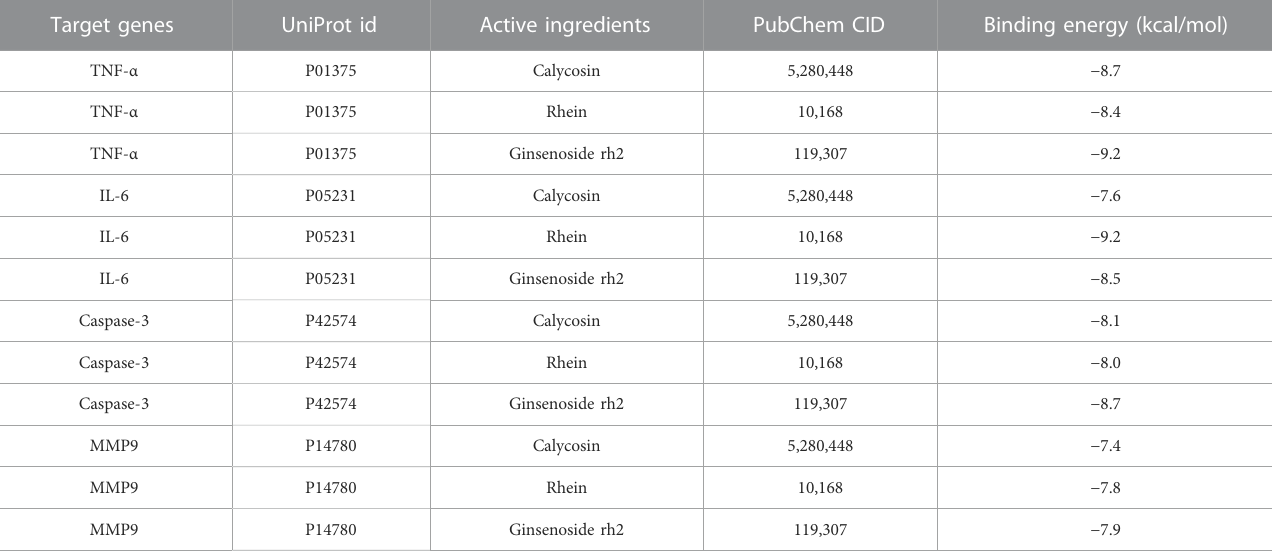
TABLE 2 Molecular docking results between ligands and core target receptors. Target